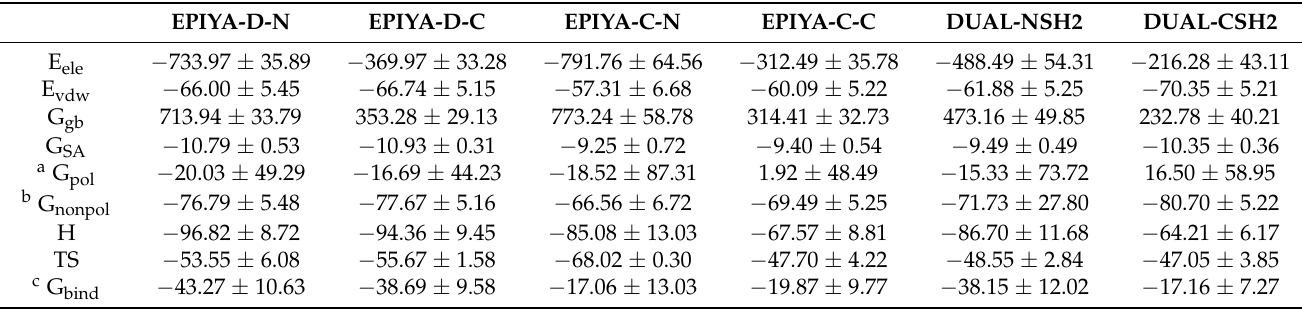
Table 2. Binding free energies (kcal mol − 1 ) and its components for complex